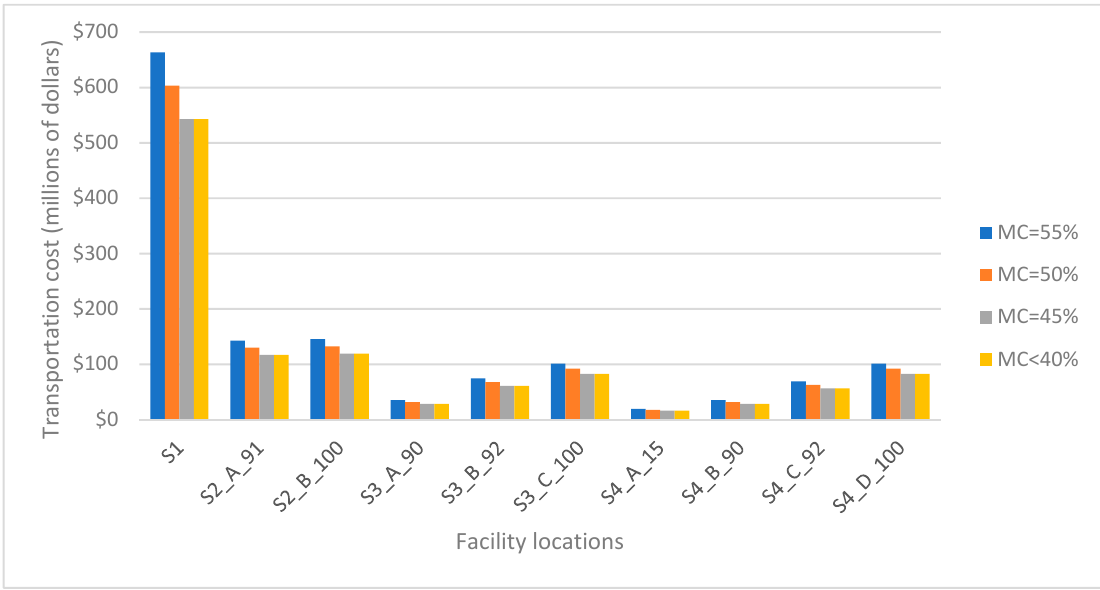
Figure 7. Impact of moisture content (MC) on transport costs (for an explanation of the facility location codes, see Figure 5).